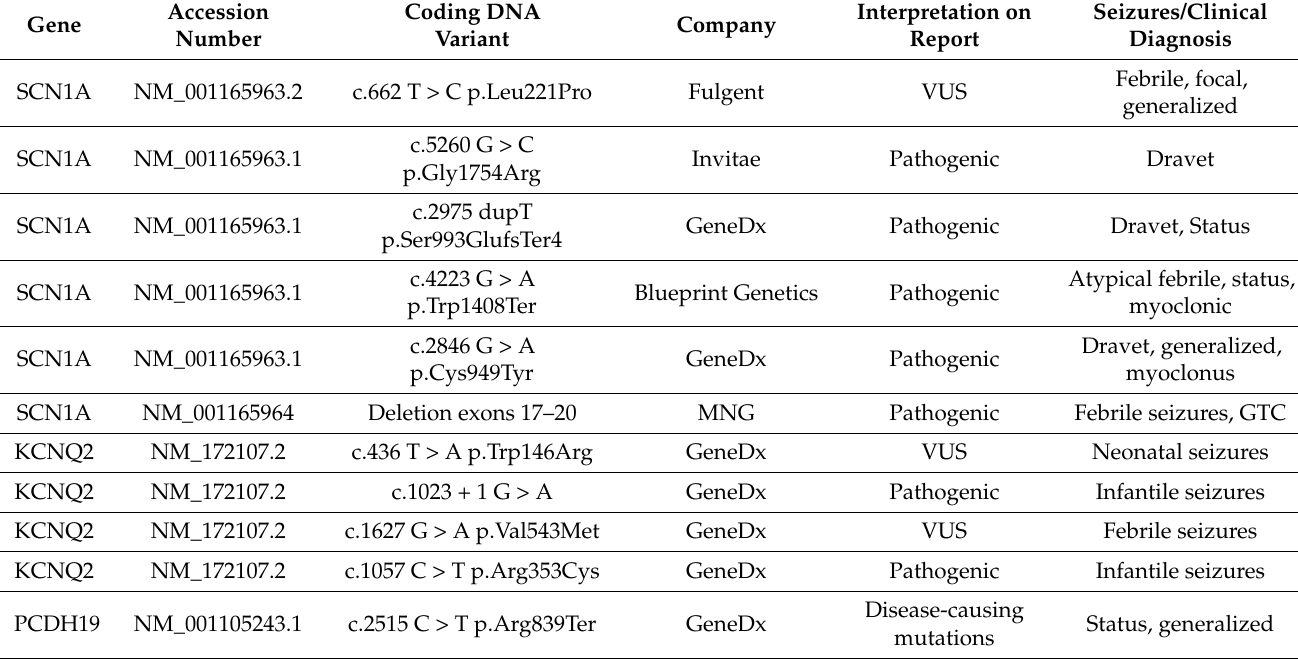
Table A1. Details of genetic variants reported as